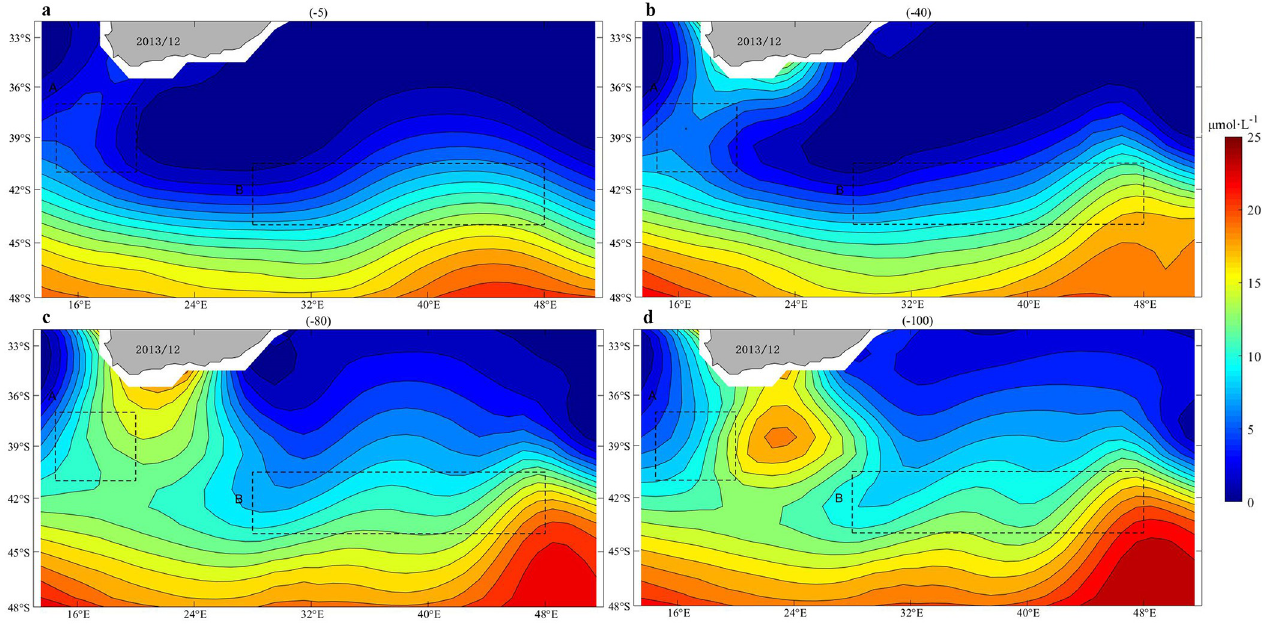
Fig 8. Climatology mean of nitrate concentrations ( μ mol � L-1) in December (the results at depths of -5 m, -40 m, -80 m and -100 m, respectively).